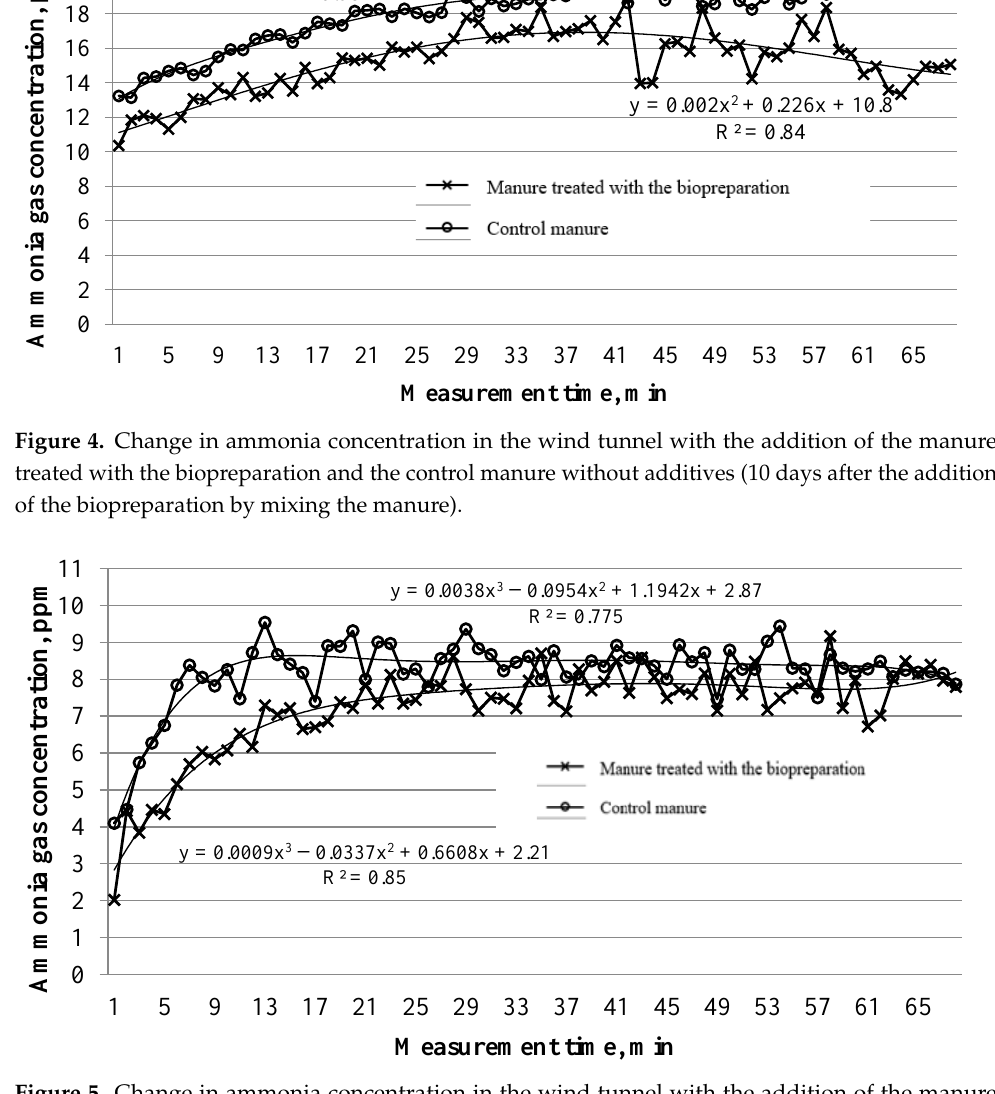
Figure 4. Change in ammonia concentration in the wind tunnel with the addition of the manure treated with the biopreparation and the control manure without additives (10 days after the addition of the biopreparation by mixing the manure).